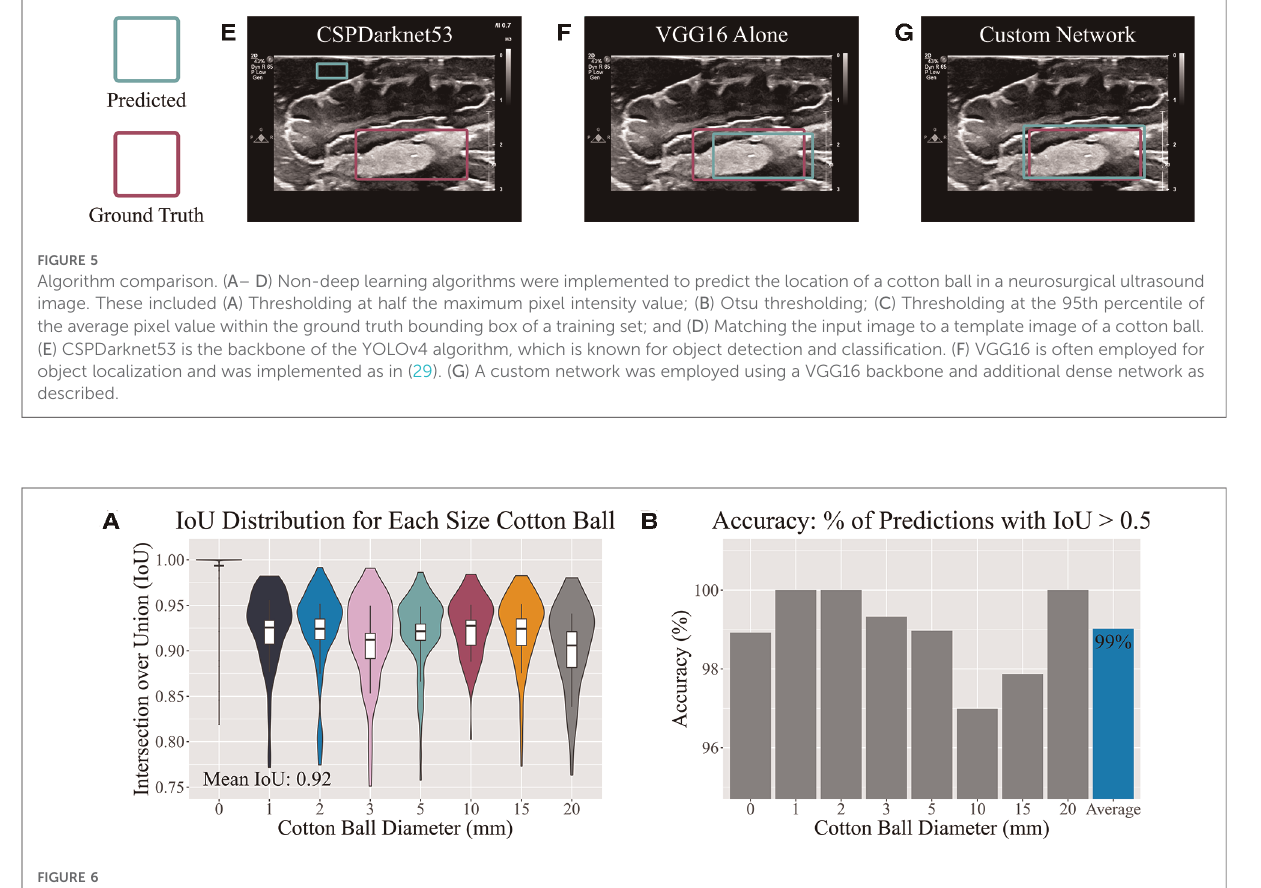
FIGURE 6 Accuracy assessment. ( A ) A distribution of Intersection over Union (IoU) values of the test set is shown for each implanted cotton ball size. Vertical boxplot lines indicate the 10th and 90th percentiles, while the boxplot itself indicates the 25th, 50th, and 75th percentiles. ( B ) Accurate predictions have IoU values greater than 50%. Here the percentage of accurately predicted bounding boxes are split by cotton ball